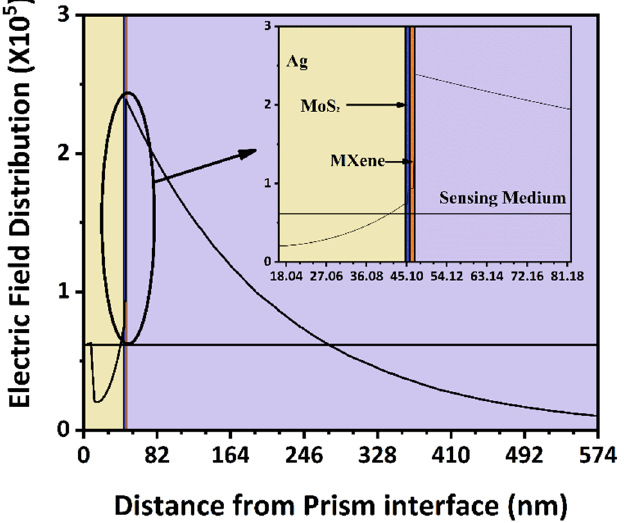
Figure 8. Electric field distribution plot along the direction normal to BK7 prism base indicating the evanescent wave at sensing boundary.